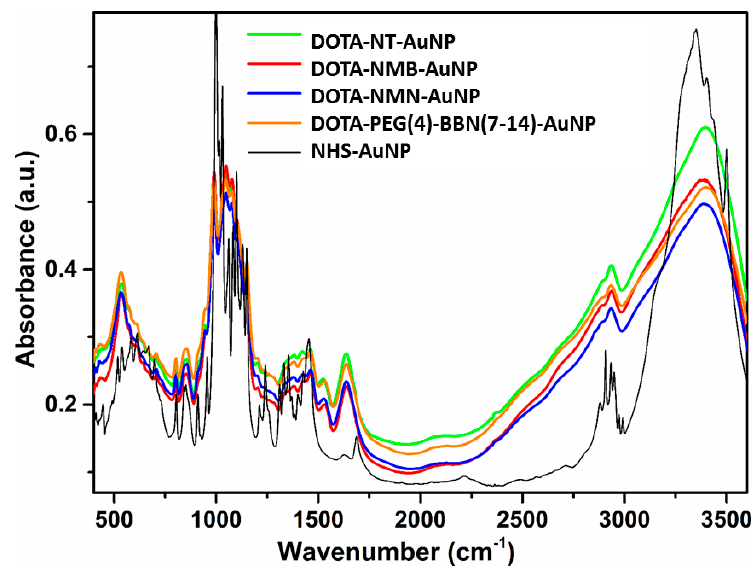
Figure 2. FTIR absorption spectra of DOTA-NT-AuNP (green), DOTA-NMB-AuNP (red), DOTA-NMN-AuNP (blue) and DOTA-PEG(4)-BBN(7-14)-AuNP (orange) and NHS-AuNP (black).